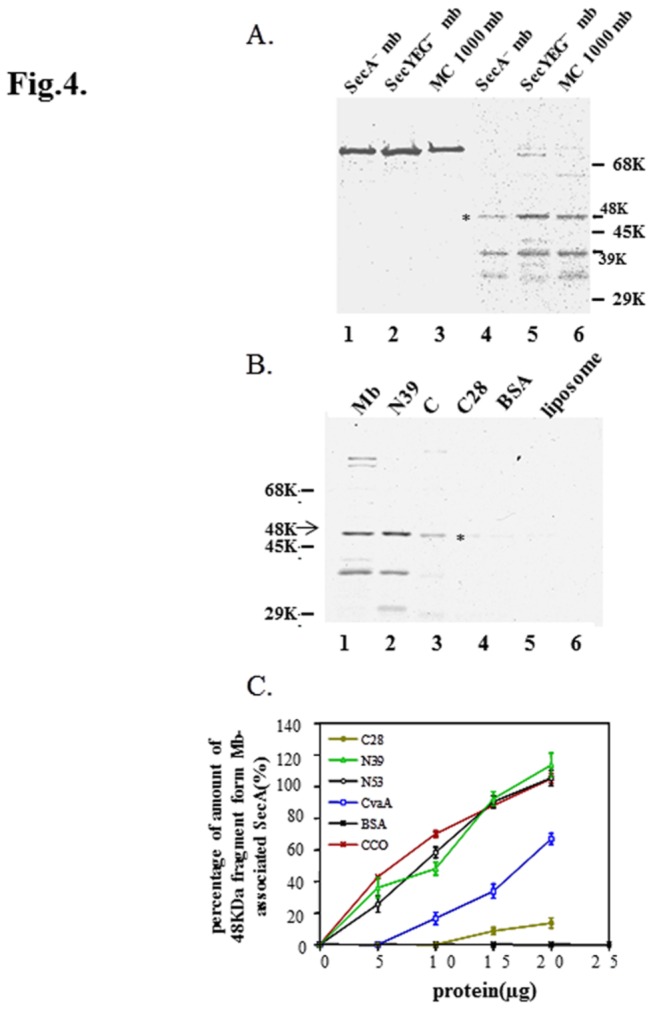
SecYEG are not required for the formation of M48(A) SecYEG-depleted membrane (20 μg), wild-type MC1000 membrane (20 μg), or SecA-depleted BA13 membrane (20 μg) was mixed with [35S]SecA (1 μg) in 100 μl DTK buffer, respectively. After pre-incubation at 37 °C for 15 min, the samples were cooled on ice and incubated for 15 mins with (lanes 4-6) or without 30 µg/ml trypsin (lanes 1-3). (B) The reactions were carried out, as in panel A, in the presence of 20 μg of membranes, N39, C28, BSA or Cytochrome C (lane 3) or liposomes alone (lane 6). (C) The reactions were carried out (as in panel B) in the presence of various amounts of N39, N53, C28, CvaA, BSA, and CCO (Cytochrome C Oxidase). The amount of M48 domain fragment in each liposomal fraction was quantitated after gel electrophoresis relative to the amount of the M48 domain obtained from mb-associated SecA (which was taken as 100%). The amount of M48 domain from CCO was calculated from immunoblots while other amounts were calculated from autoradiograms. The data were from 2-4 sets of independent experiments, and presented as mean + SE.